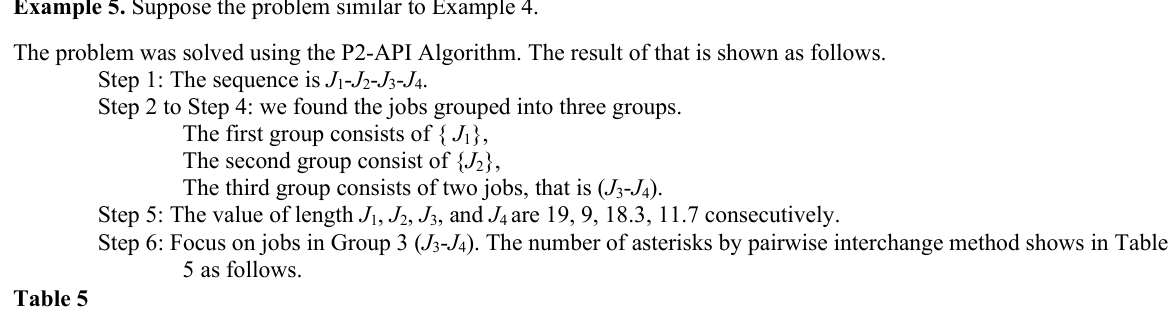
The result of the adjacent pairwise interchange (API) method